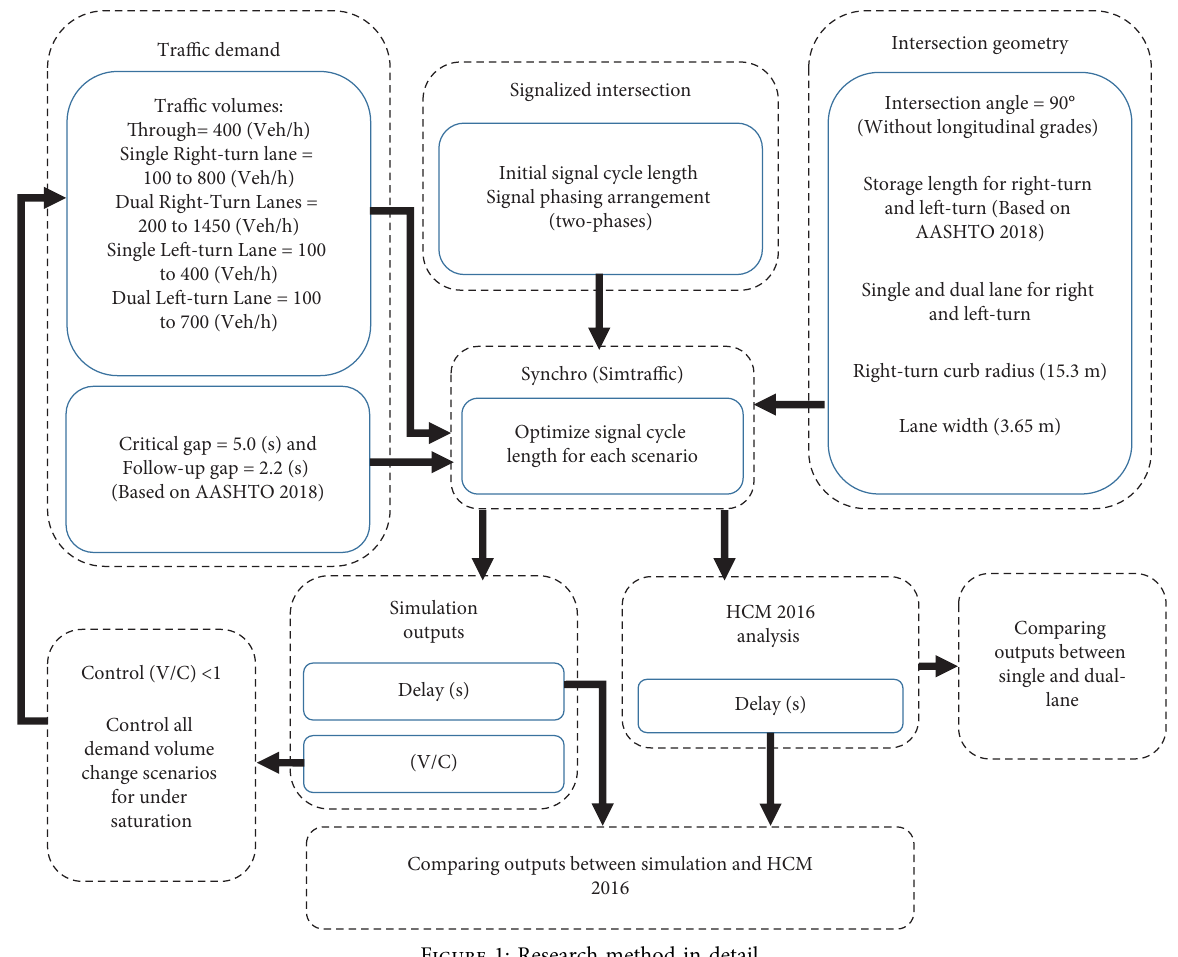
Figure 1: Research method in